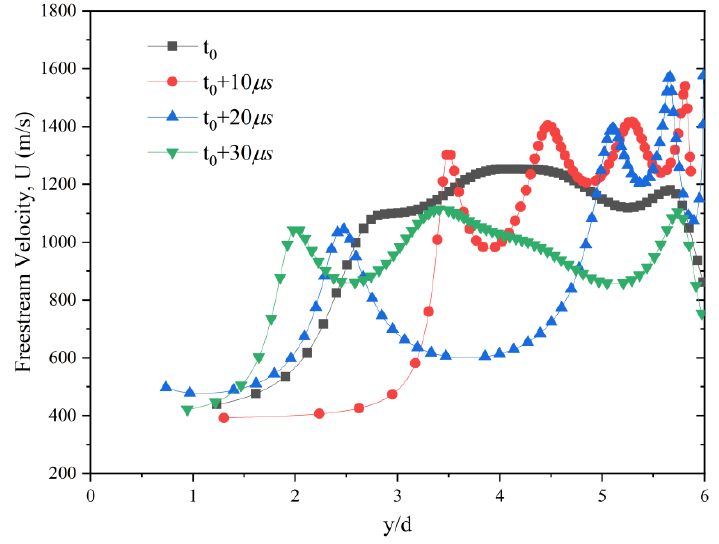
Figure 11. The mainstream velocity (U) along the longitudinal direction behind the bow shock.